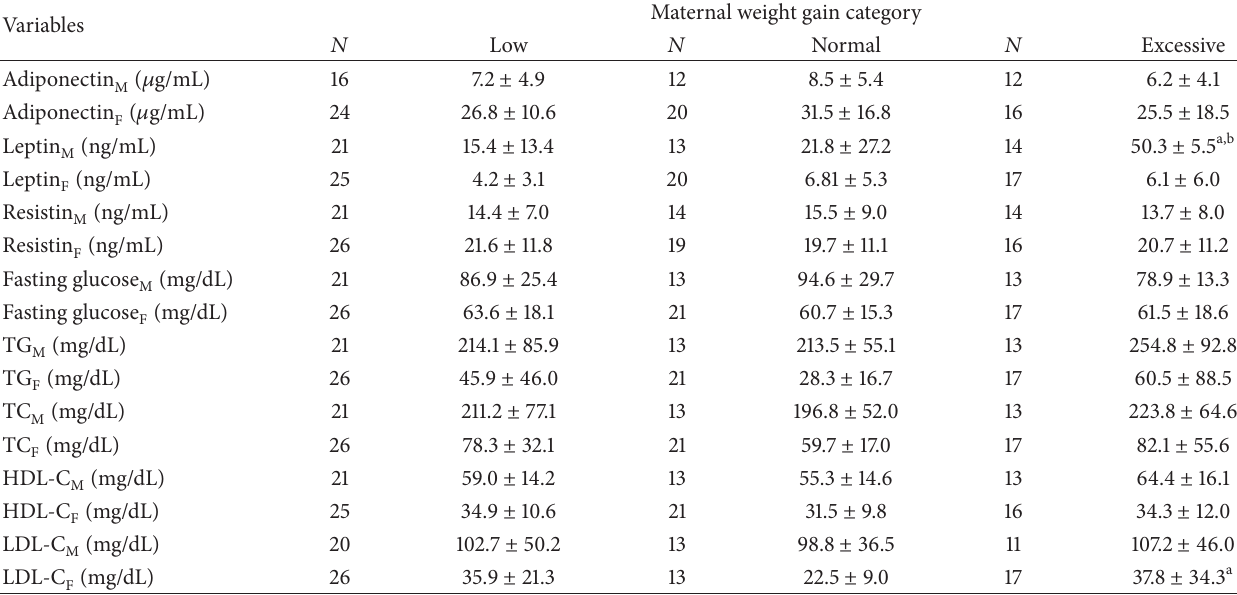
Table 3: Maternal and fetal adipokine and lipid profiles according to maternal weight gain status.